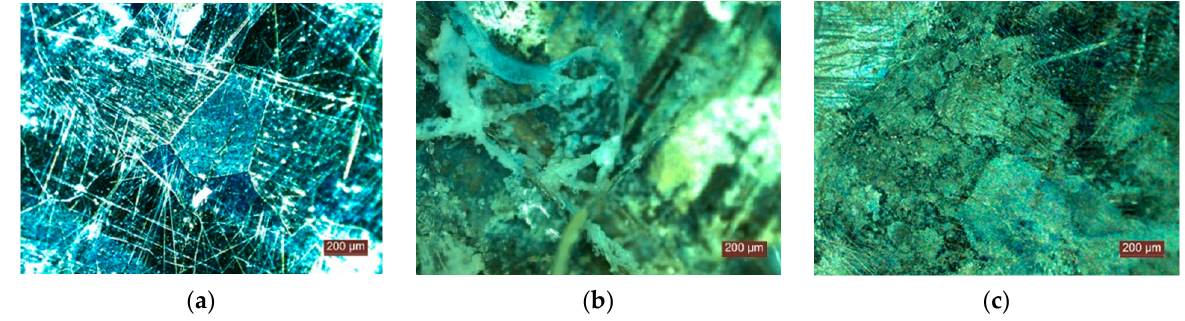
Figure 10. Evolution of the appearance of galvanised steel specimens: ( a ) initial appearance of the metal specimen; ( b ) appearance of the metal specimen after testing; ( c ) appearance of the metal specimen after testing and washing of corrosion products.